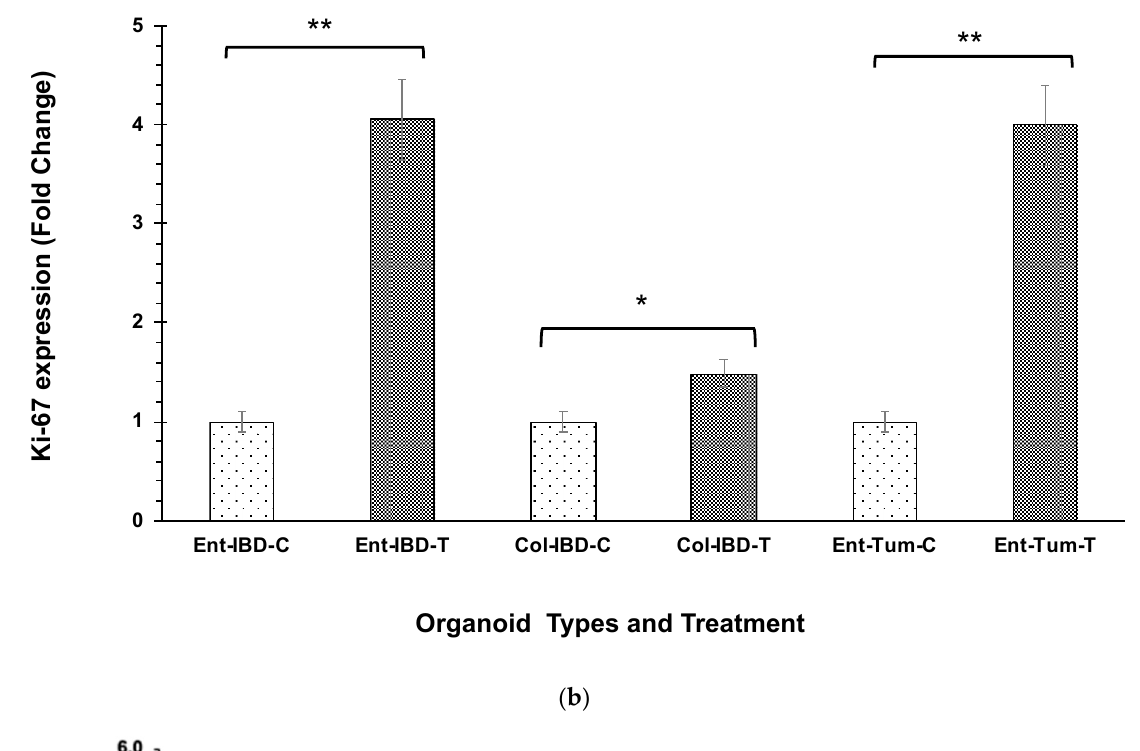
( d ) Figure 1. LPS stimulates higher proliferation. ( a ) Enteroids and colonoids from dogs with IBD and intestinal mast cell tumor, 48 h after LPS stimulation. Representative phase-contrast images of en- teroids and colonoids after LPS stimulation. The control group received complete growth medium, whereas the LPS group received LPS 5 μ g/mL in complete growth medium. ( b ) Expression of Ki-67 in enteroids and colonoids from dogs with IBD and intestinal mast cell tumor, 48 h after LPS stim- ulation as measured by qPCR. The control group received complete growth medium, whereas the LPS group received LPS 5 μ g/mL in complete growth medium. GAPDH was used to normalize. Ent-IBD-C: control IBD enteroids; Ent-IBD-T: IBD enteroids following LPS stimulation; Col-IBD-C: control IBD colonoids; Col-IBD-T: IBD colonoids following LPS stimulation; Ent-Tum-C: control tu- mor enteroids; Ent-Tum-T: tumor enteroids following LPS stimulation. Histograms represent the mean Ki-67 expression (fold change) ± SD of four technical replicates used in the qPCR experiment.